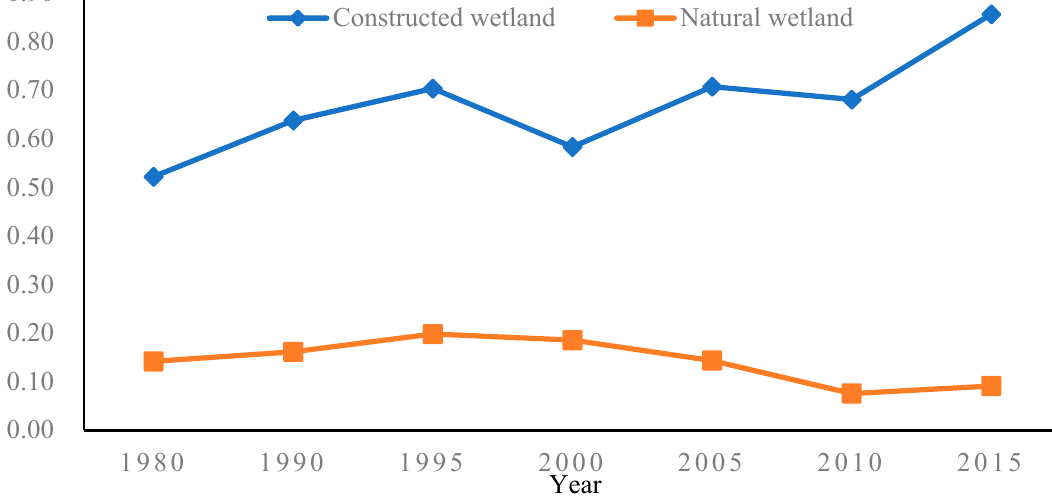
Figure 3. Patch area (PA) of constructed and natural wetland from 1980 to 2015. The patch density of the wetland landscapes in Henan Province are shown in Figure 4. The PD values of constructed wetlands (paddy field and reservoirs and pond) were rela- tively high, indicating high degree of landscape fragmentation. Combined with Figure 3, the PA values of constructed wetland increased year by year, the number of patches also increased.